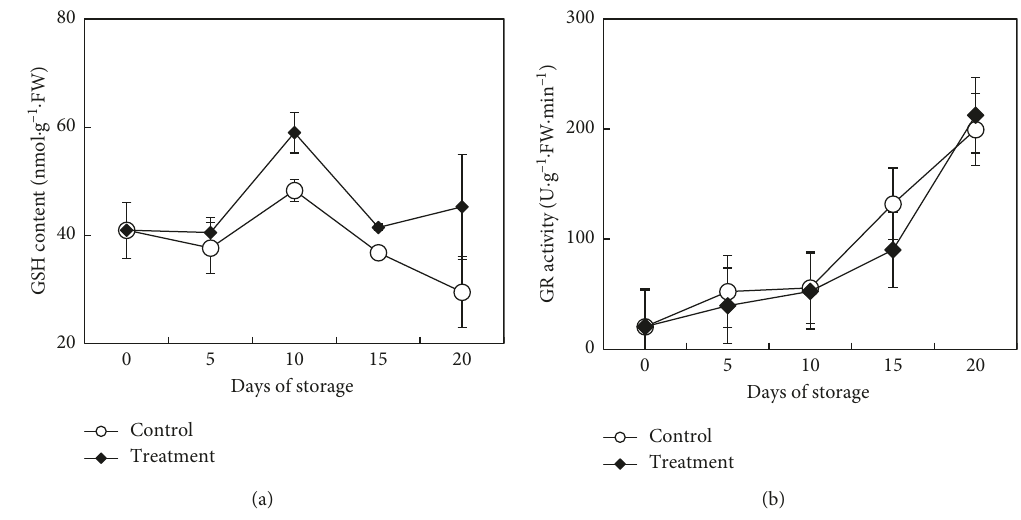
Figure 9: Effects of forced air precooling treatment on GSH content (a) and GR activity (b).